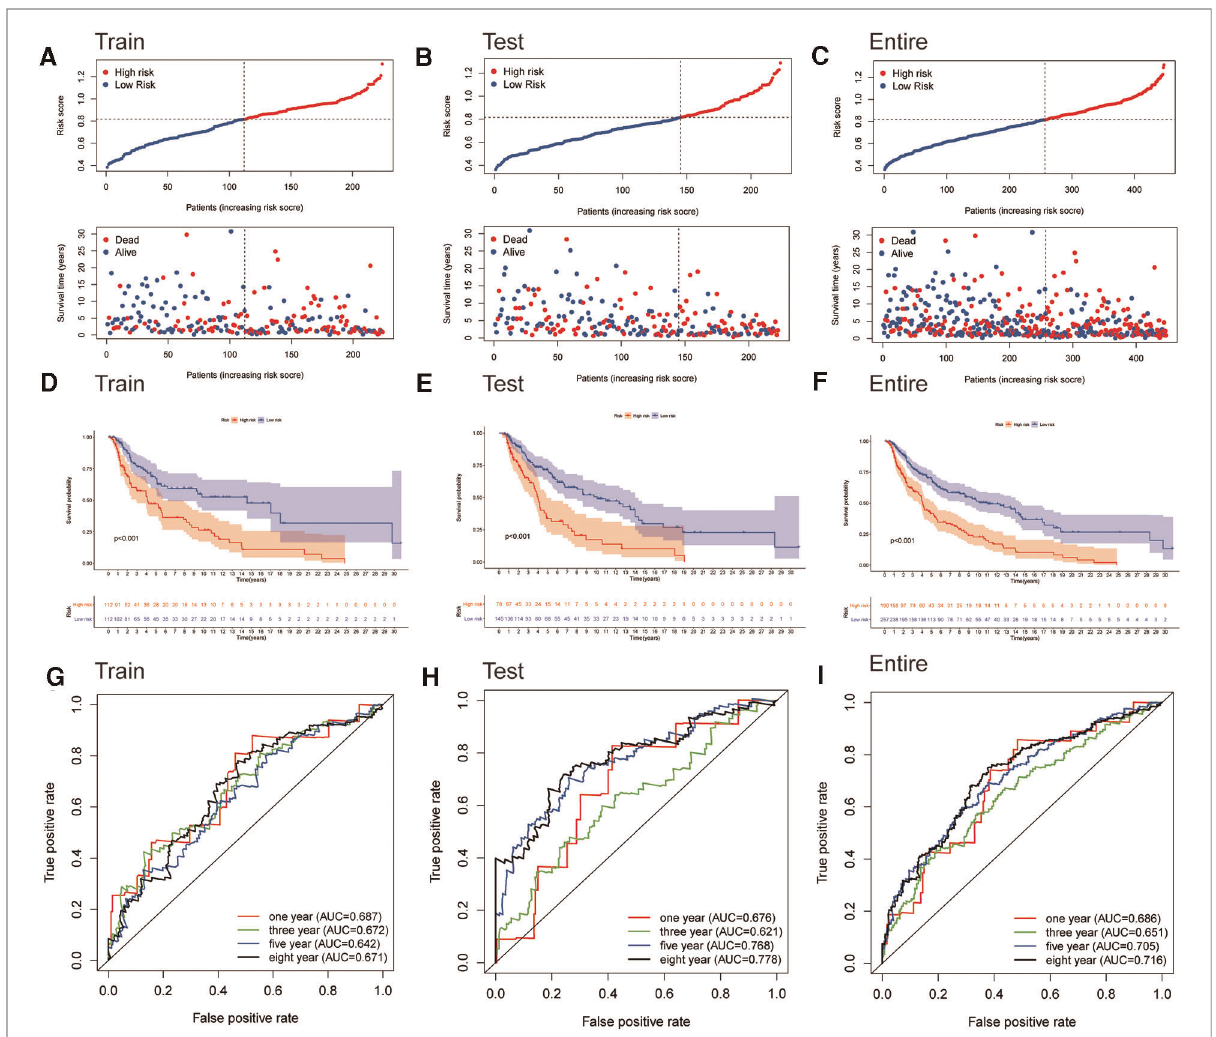
FIGURE 3 Assessment of the prognostic signature for melanoma. ( A – C ) Distributions of risk scores and OS status in the training, testing, and entire cohorts, respectively. ( D – F ) Kaplan-Meier survival analyses of the signature for the training, testing, and entire cohorts, respectively. ( G – I ) ROC curve of the prognostic signature in the training, testing, and entire cohorts,